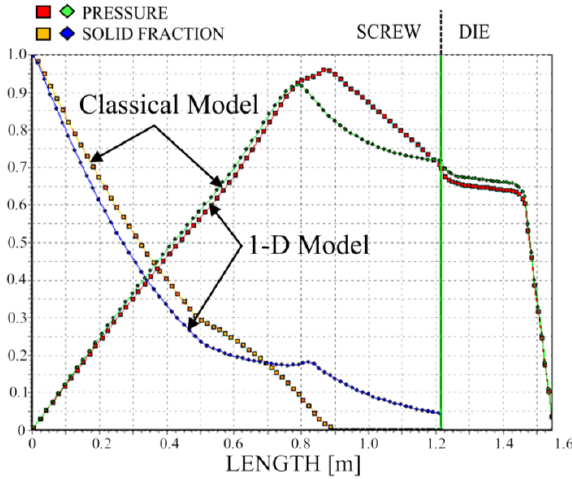
Figure 13. Solid bed profile and pressure profile for 1-D and 2-D simulations, N = 80 rpm.